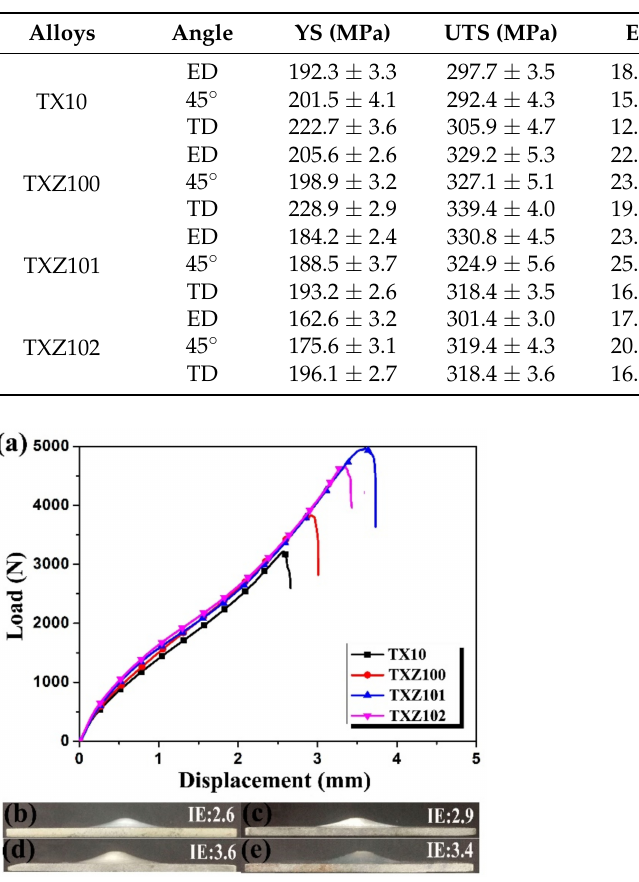
Figure 4. The true tensile stress–strain curves of the as-extruded Mg-1.0Sn-0.5Ca-xZn alloys: ( a ) TX10 alloy; ( b ) TXZ100 alloy; ( c ) TXZ101 alloy; ( d ) TXZ102 alloy. Table 3. Summary of the tensile properties at room temperature consisting of the YS, UTS, EL, n-value, and rave values of the four as-extruded Mg-1.0Sn-0.5Ca-xZn series alloys.